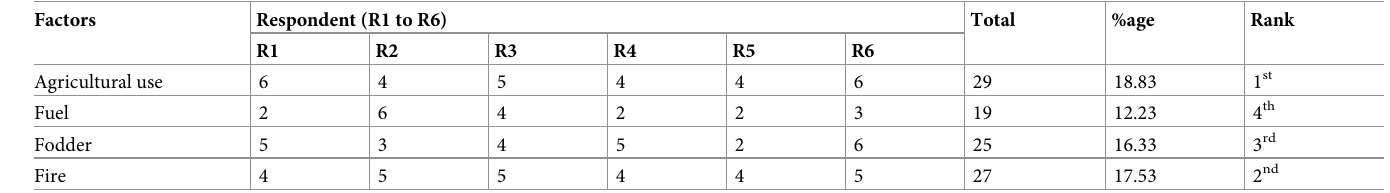
Table 10. Priority Ranking (PR) of factors apparent as threats to plant diversity on the basis of their level of critical effects in the SMR of district Bhimber (destruc- tive order is; 4 < 3 < 2 < 1 = 4 is highest destructive value).